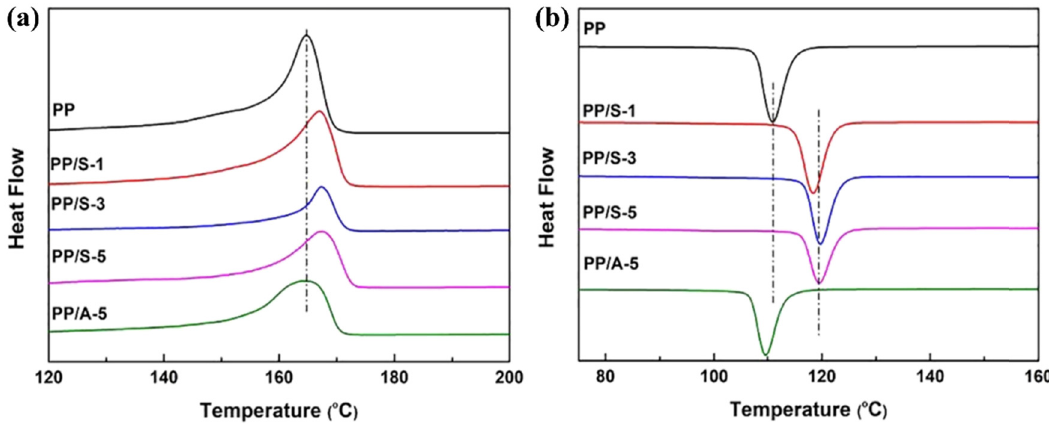
Figure 12: ( a ) Melting curves, and ( b ) crystallization curves of PP and PP nanocomposites. PP nanocomposites are called PP/SX or PP/AX, S and A stand for PP - g - SiO 2 and PP - MAH/A200 masterbatch, both masterbatches contain 15 wt% nano - SiO 2 . X is the fi nal particle loading in the PP nanocomposite [ 75 ] ; Copyright: 2020 with permission from Wiley.